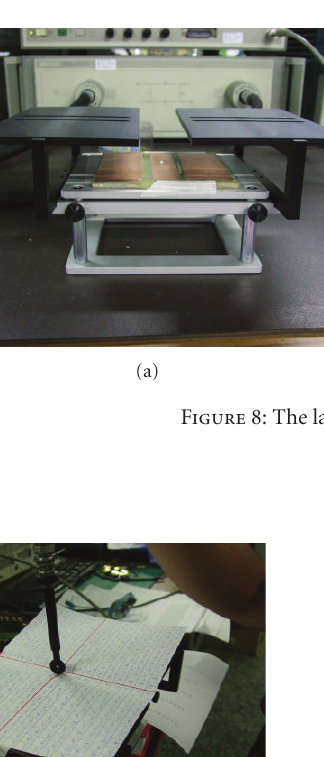
Figure 7: Measured return loss.